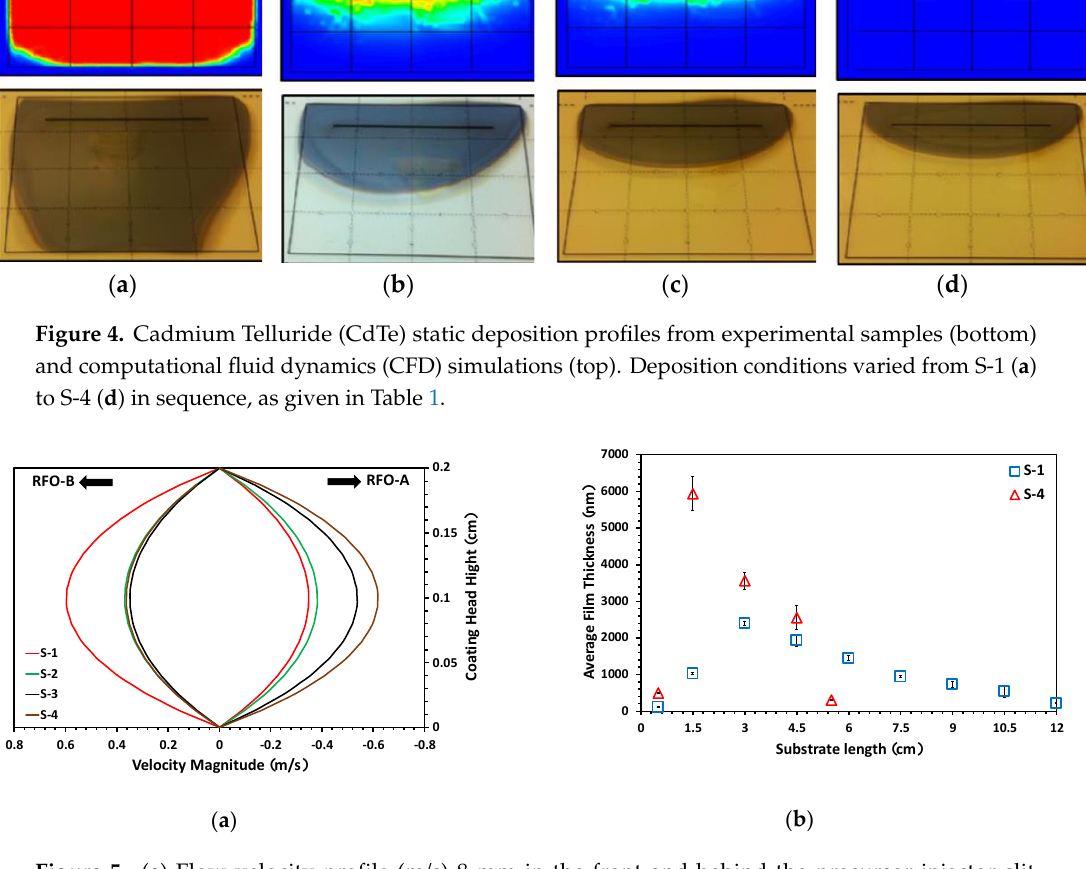
Figure 6. Path lines located behind the precursor injector slit (i.e., near RFO-A in Figure 1) around the flow guide plate and the exhaust ( a ) for S-1 and ( b ) for S-4.